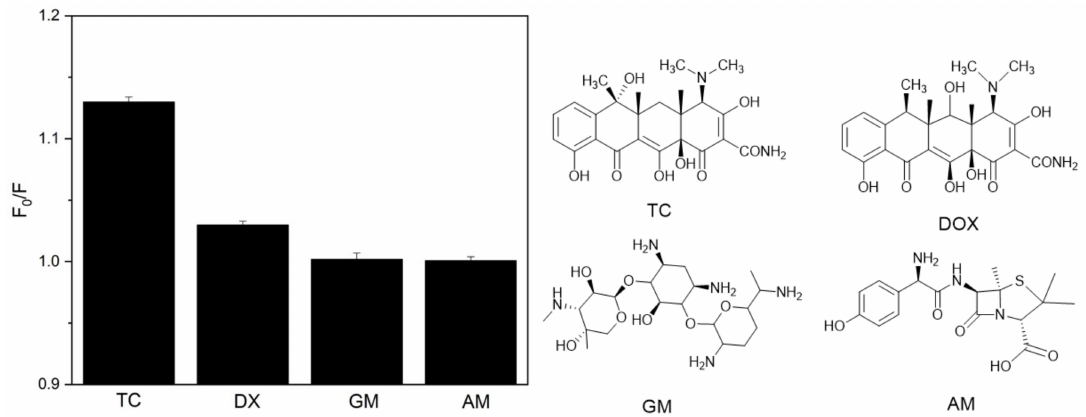
Figure 6. Selective adsorption of TC, DOX, GM and AM by GQDs-MIPs in water. The concentration of all compounds was 10 4 µ g L − 1 .